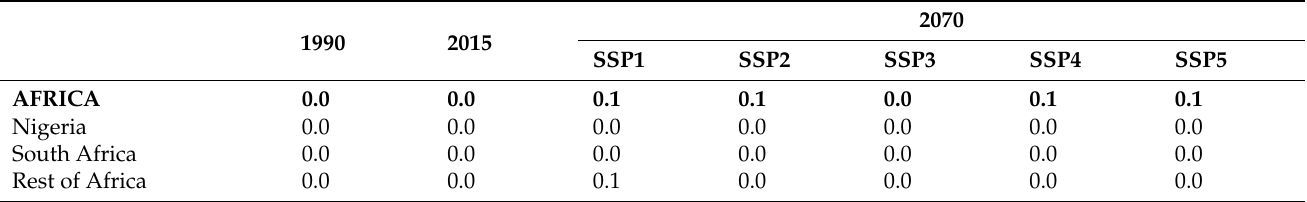
Table A4. Wood pellet consumption (million metric tons), 1990 to 2015 historic, 2070 projections from